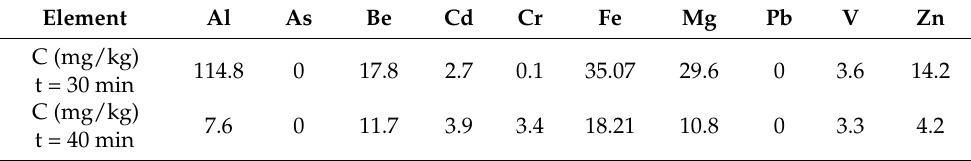
Table 3. Concentrations of elements present in the waste at different treatment times obtained by ICP.